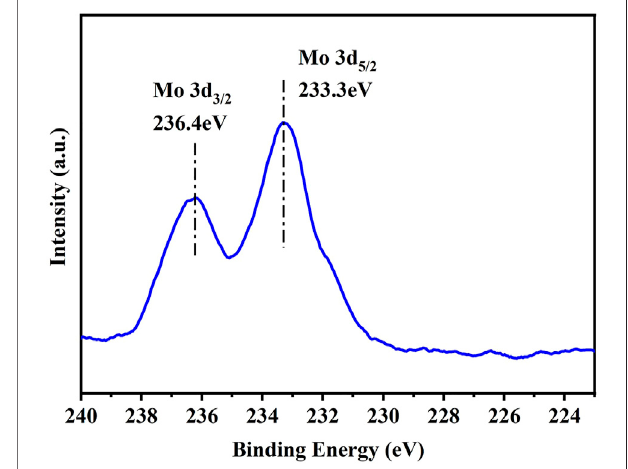
FIGURE 2 | Mo 3 days XPS spectrum of Mo-modi fi ed Sn- β